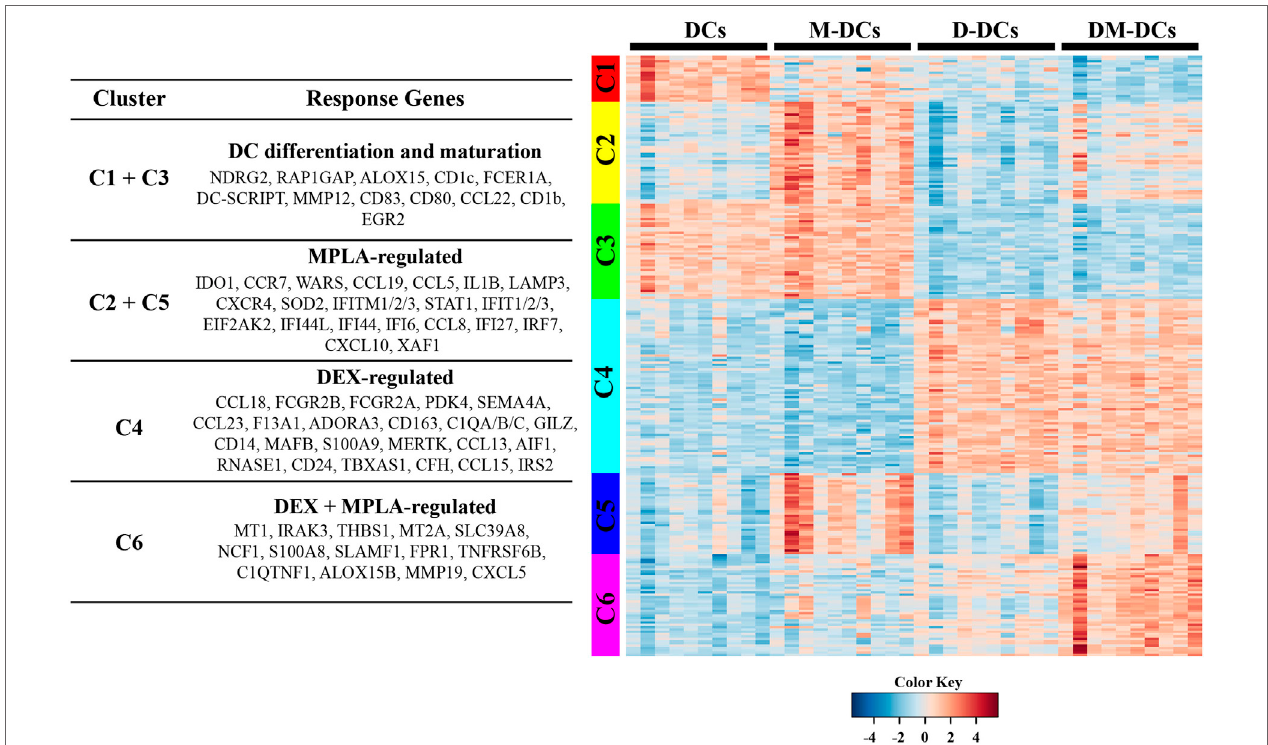
FigUre 3 | Transcriptional program of dexamethasone (Dex)-modulated and monophosphoryl lipid A (MPLA)-activated dendritic cells (DM-DCs) is the result of gene expression regulation by an interplay between dexamethasone and MPLA. A clustering analysis was performed using a K-means clustering of the residual values of the 259 differentially expressed transcripts found on DM-DCs versus DCs. Each cluster is represented by a different color band. Clusters that shared a similar inferred response toward stimuli used were further grouped, and representative genes for each group are shown in the left and in Table S3 in Supplementary